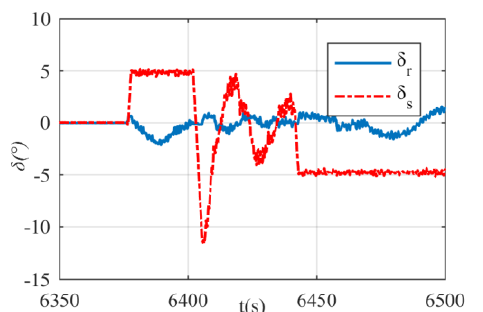
Figure 17. Virtual rudder commands from DIFC. The first stage (6375–6400 s), The second stage (6400–6445 s), The third stage (6445–6500 s).